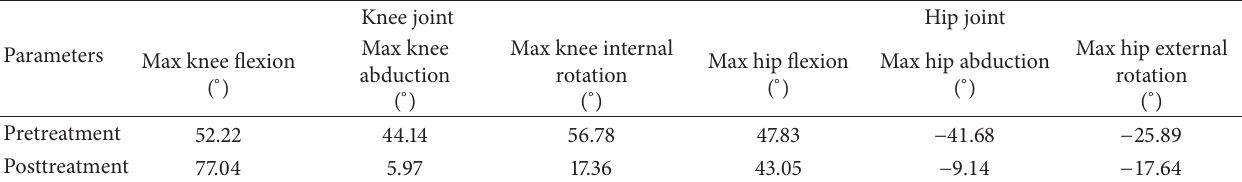
Table 2: The kinematics of the hip and knee joints maximum degree during pre- and posttreatment in ITV.